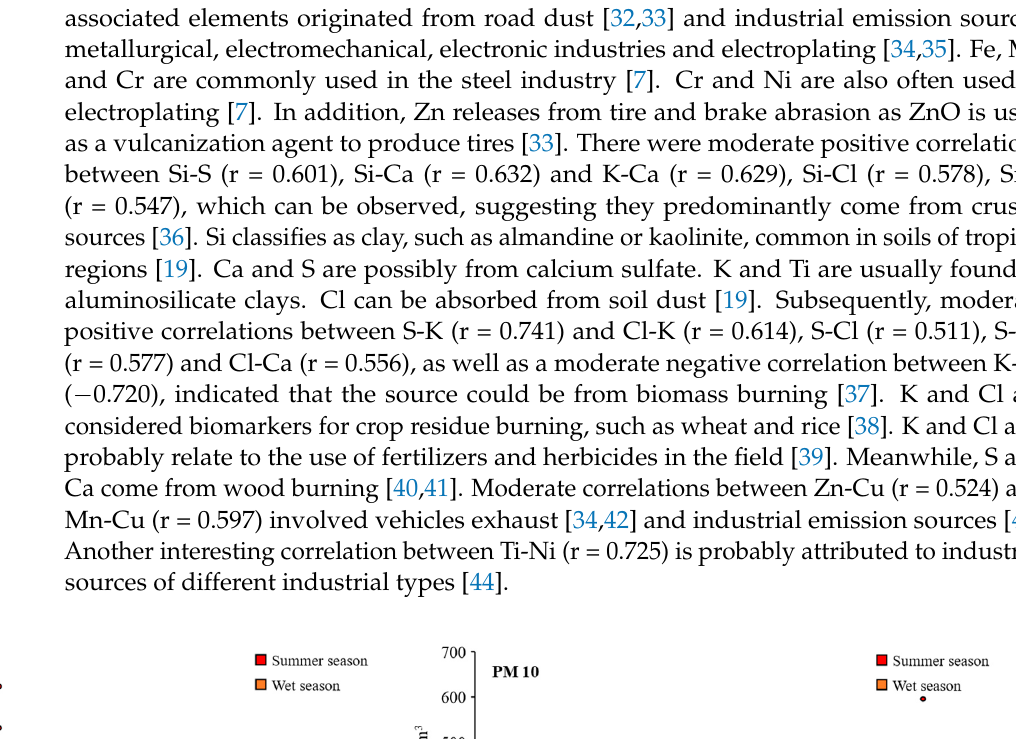
Figure 3. Variation of elements concentrations of PM 2.5 and PM 10 samples over Pathum Thani Province from 18 February to 14 September 2021.